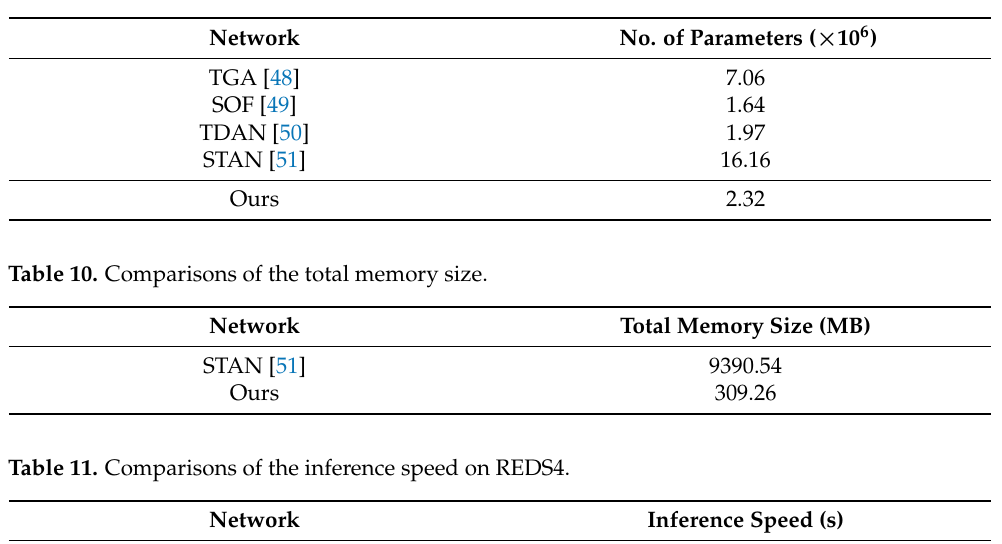
Table 9. Comparisons of the number of parameters.